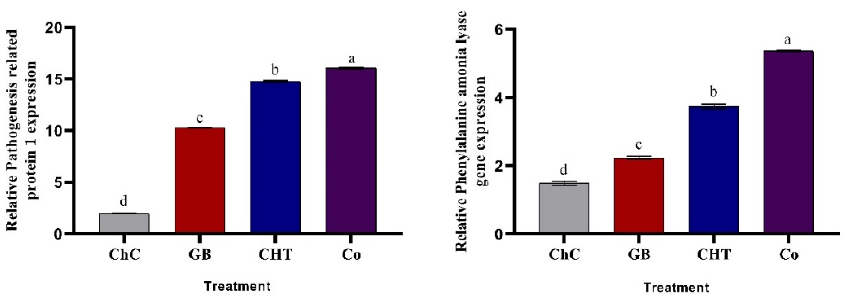
gene expression of relative pathogenesis related protein 1 ( PR1 ) and relative phenylalanine ammonia